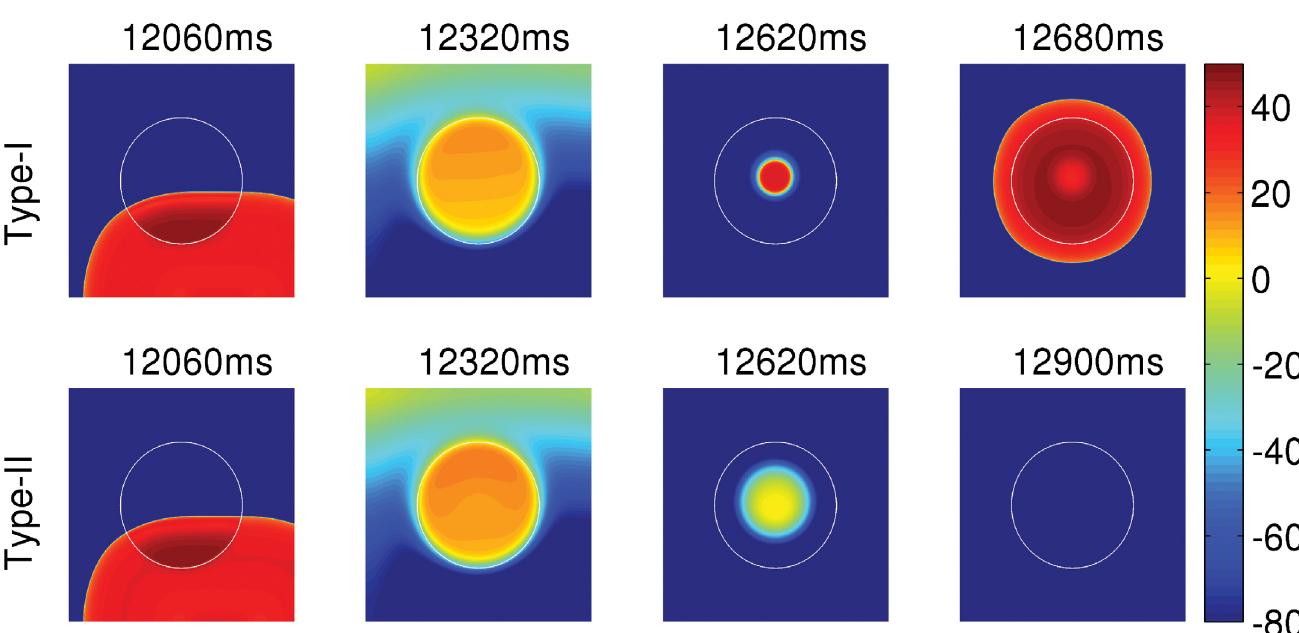
Fig 3. The dependence of PVCs on the repolarization reserve (RR). Pseudocolor plots of V m showing its spatiotemporal evolution, when the tissue is paced at PCL = 1000 ms with EAD clumps of radius R = 2.4 cm, but two different types of APs: Type-I AP (top panel) and type-II AP (bottom panel). The white circular contour marks the periphery of the EAD clump, where the cells inside and outside the contour are EAD and normal cells, respectively. The clump with a type-I AP triggers PVCs, whereas the clump with a type-II AP does not trigger PVCs.